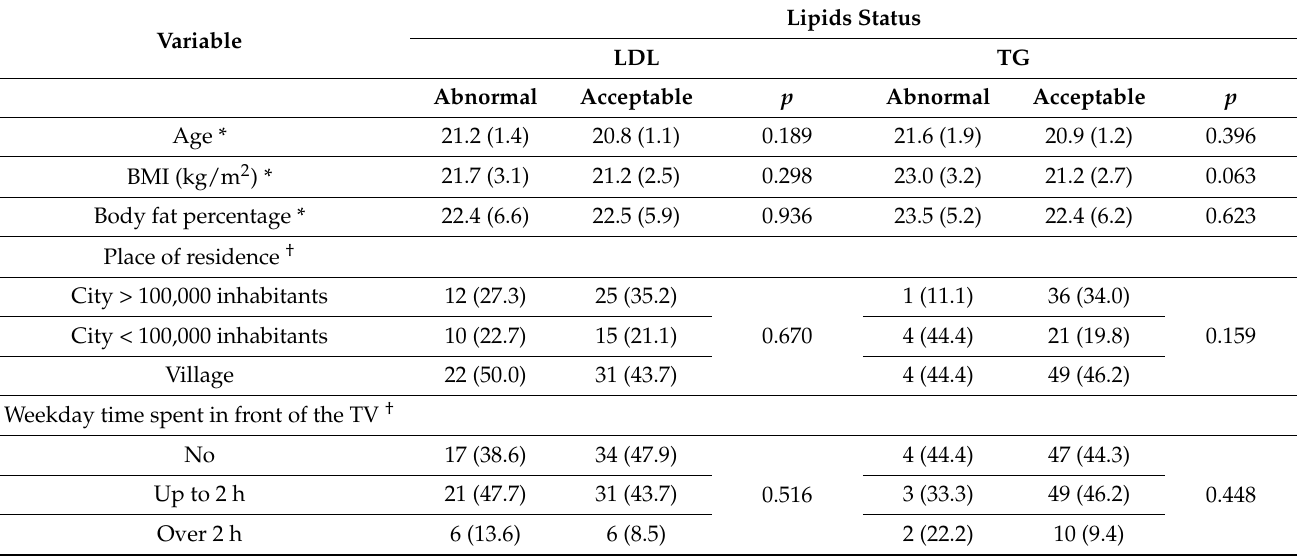
Table 6. Variables that influence the prevalence of abnormalities of LDL and